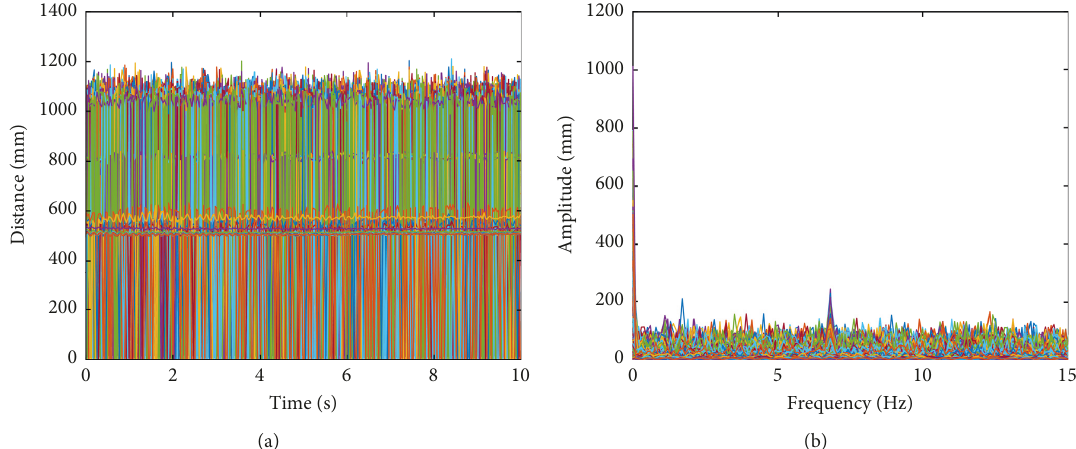
Figure 25: (a) Raw distance time history of each pixel (overlaying plot) from Kinect depth information. (b) Corresponding frequency- domain result obtained by FFT.